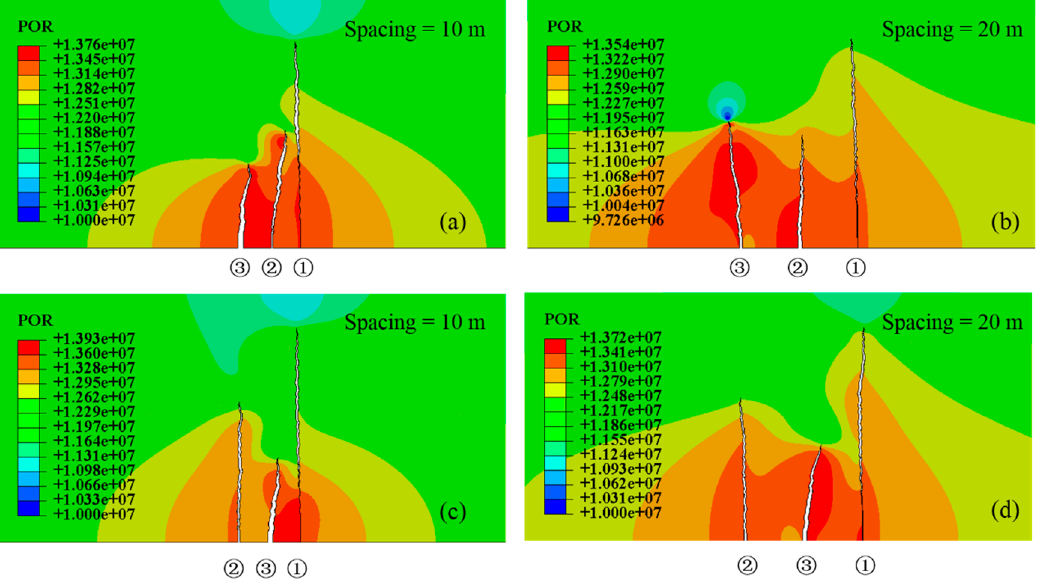
Figure 11. Fracture geometries of sequential and alternative sequential fracturing with different closely-spacing (POR is the pore pressure: Pa): ( a ) Fracture geometries of sequential fracturing with spacing = 10 m; ( b ) Fracture geometries of sequential fracturing with spacing = 20 m; ( c ) Fracture geometries of alternative sequential fracturing with spacing = 10 m; ( d ) Fracture geometries of alternative sequential fracturing with spacing = 20 m.